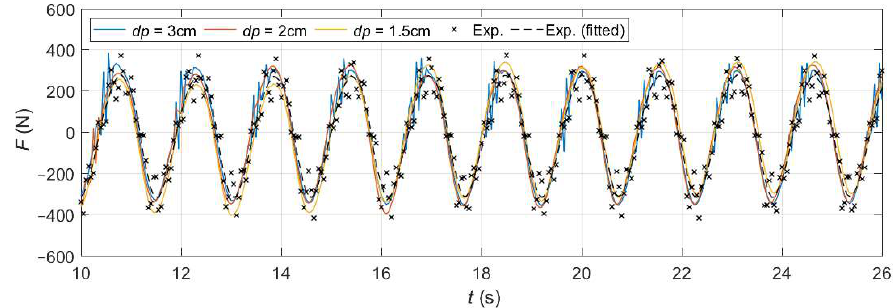
Figure 11. Numerical and experimental time series of the force for three values of dp . Table 3. Number of particles, number of total time steps, runtime and index of agreement for three values of dp .